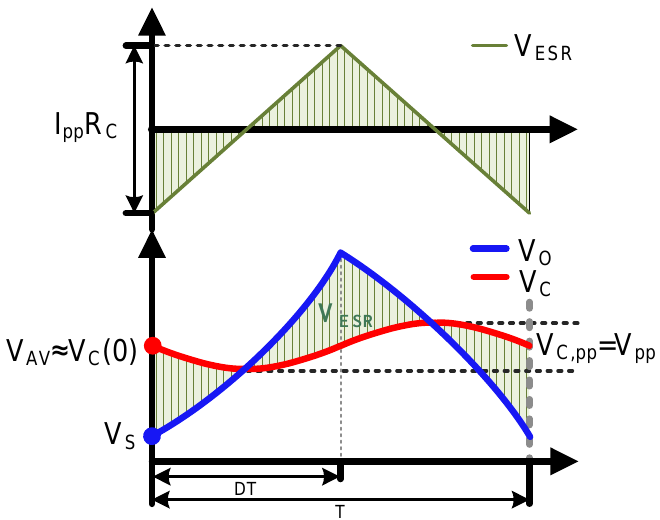
Figure 5. Output voltage and voltage between the ideal